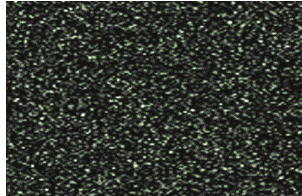
Figure 12: The encrypted image using the encryption method in fractional-order Chua system (8) as in Section 4.